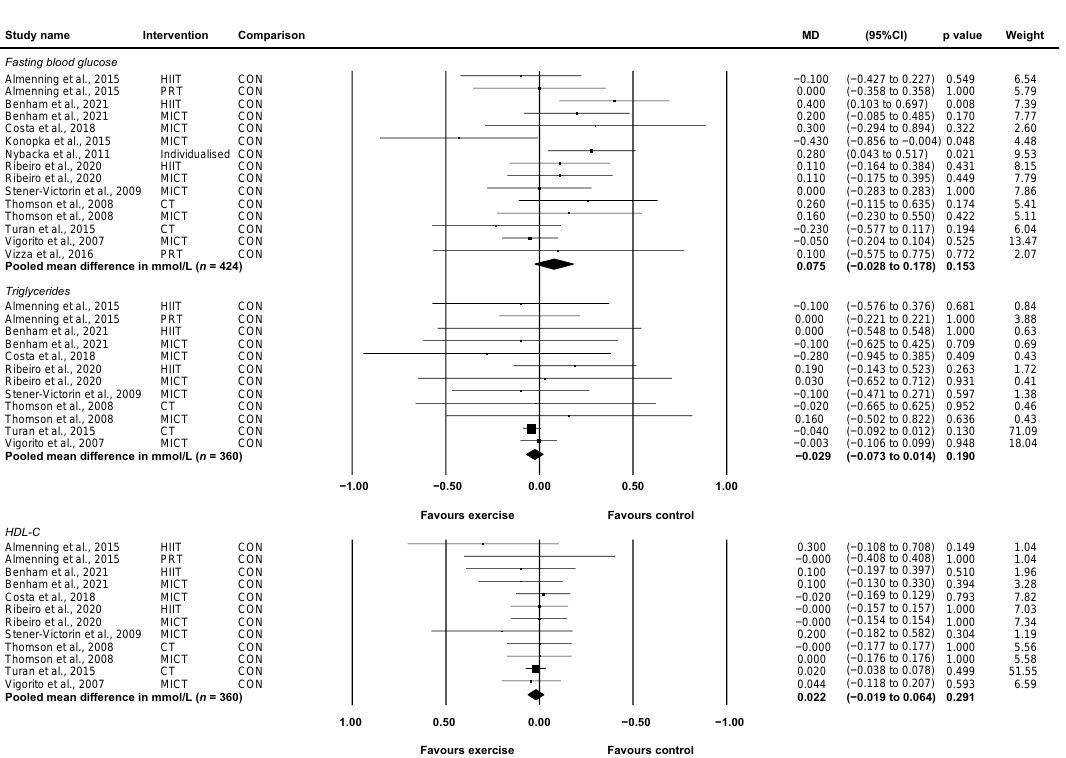
21 of 29 Figure 5. Effect of exercise vs. control for change in HOMA-IR. CI: confidence interval, CT: concur- rent training, HIIT: high-intensity interval training, MICT: moderate-intensity continuous training, MD: mean difference, PRT: progressive resistance training.